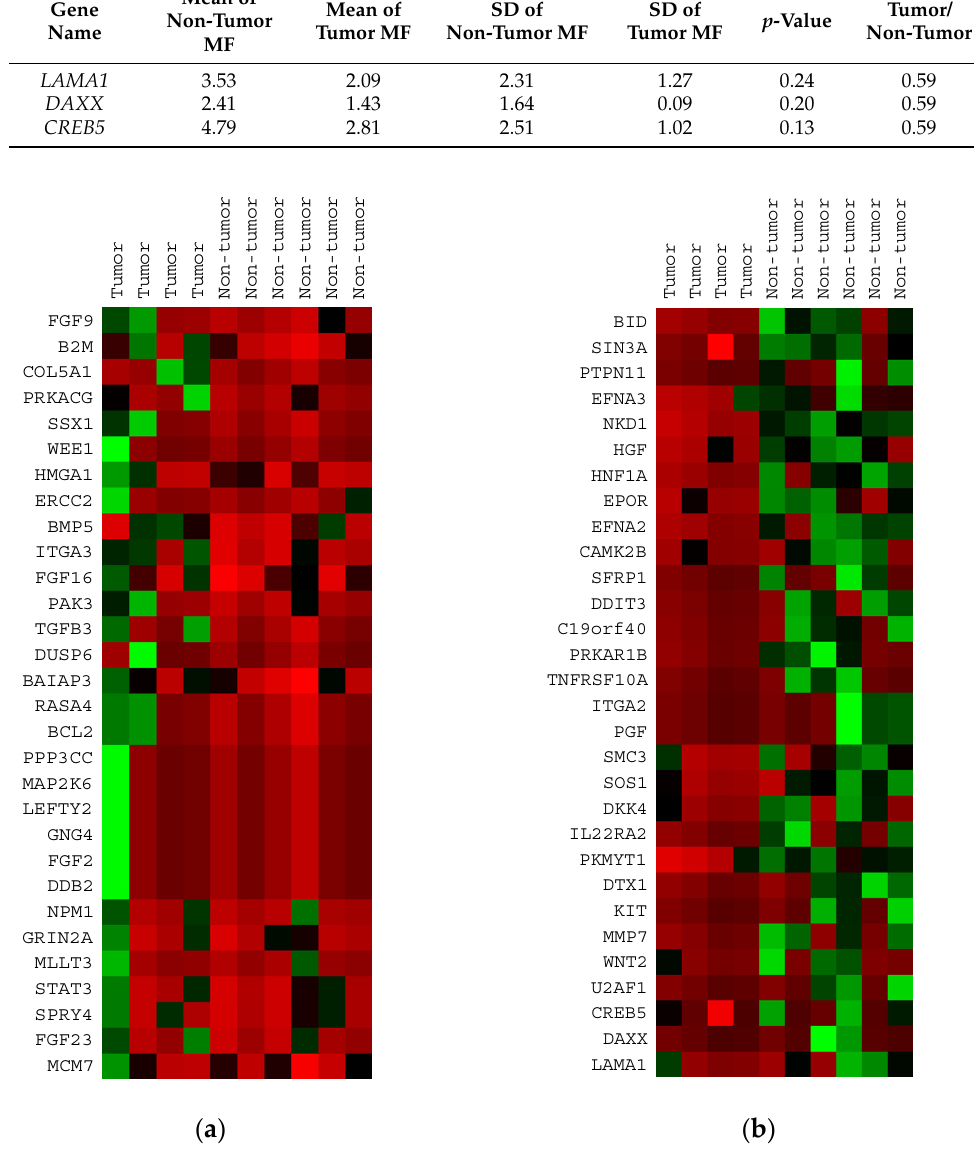
Figure 2. ( a ) Heat map of the 10 MF samples generated using the 30 most upregulated genes in tumor MF (i.e., the genes with the highest tumor/non-tumor MF ratio). The 6 non-tumor samples show a pattern of red shading indicating low gene expression, while the 4 tumor samples show a pattern of green shading indicating high gene expression. ( b ) Heat map off the 10 MF samples generated using the 30 most downregulated genes in MF. The 6 non-tumor samples show a pattern of green shading indicating high gene expression, while the 4 tumor samples show a pattern of red shading indicating low gene expression. Table 1. Summary of the 30 genes most upregulated in tumor MF based on the tumor/non-tumor MF ratio.